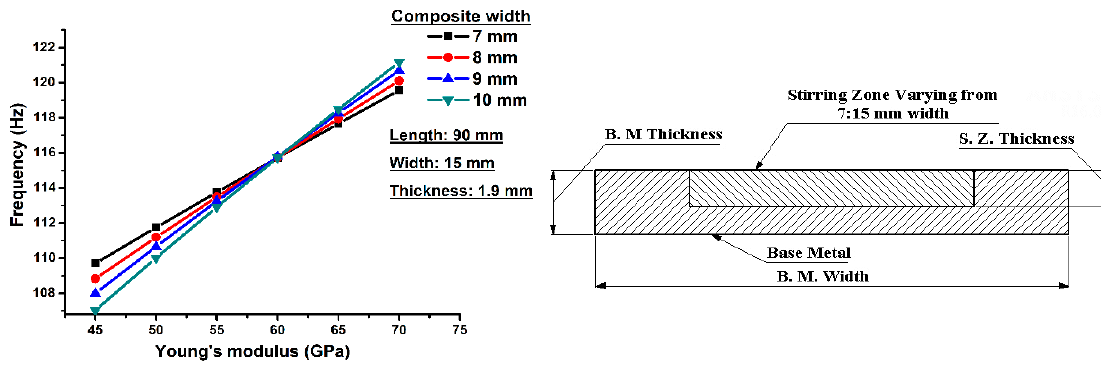
Figure 8. Effect of the width of the composite surface on the dynamic response with variable Young’s modulus.